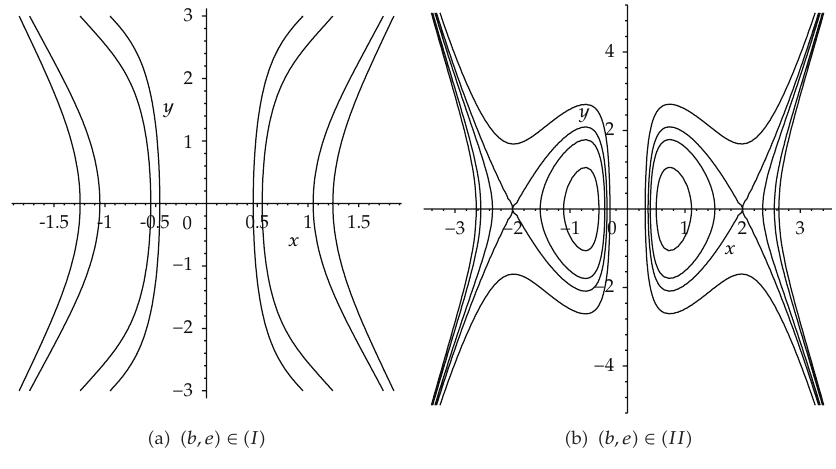
Figure 2: The phase portraits of (cid:8) 2.1 (cid:9) for a >